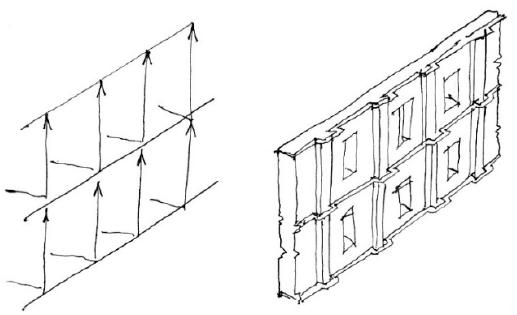
Figure 1. The essence of tectonic planning is the coherence between the load bearing structure and the building’s membrane.